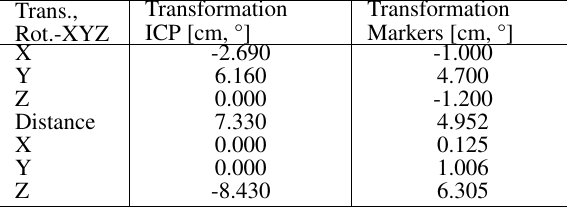
Figure 8. Initial point cloud of the first printed segment transformed to the robot base frame.